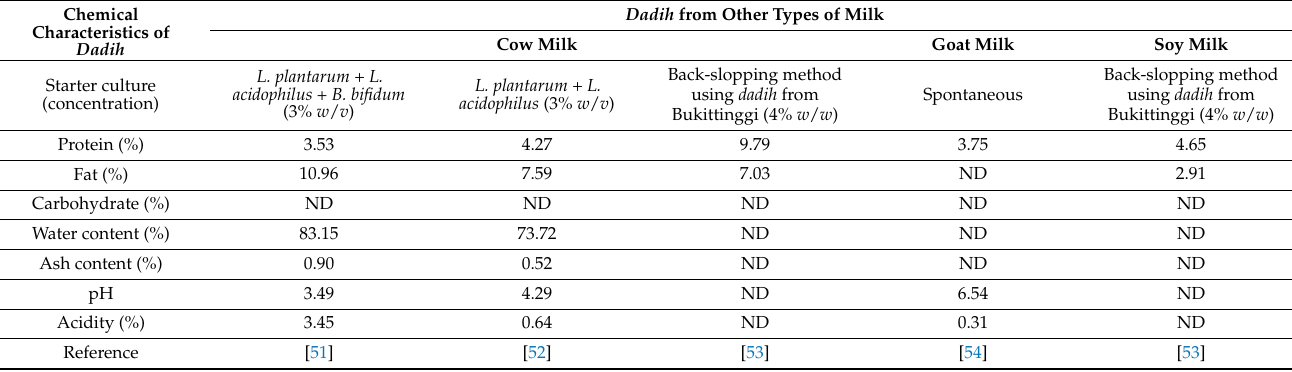
Table 4. Nutritional value of developed dadih —fermented milk made from different types of